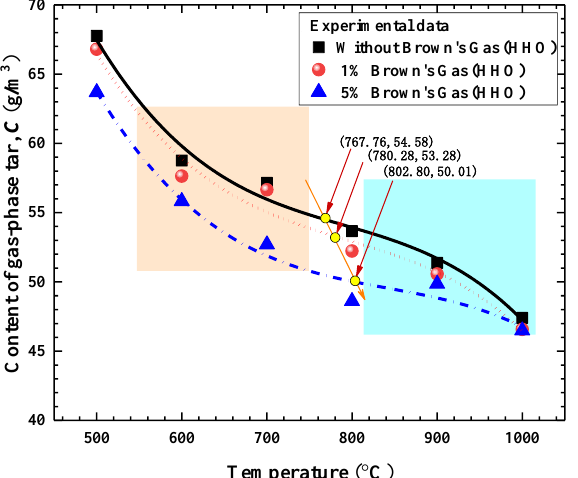
Figure 9. Variation of gas-phase tar with temperature.